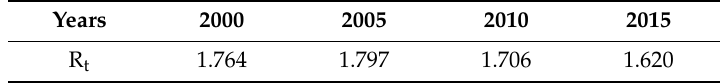
Table 2. Adjustment coe ffi cient of NPP in Shangzhou district from 1980 to 2015.